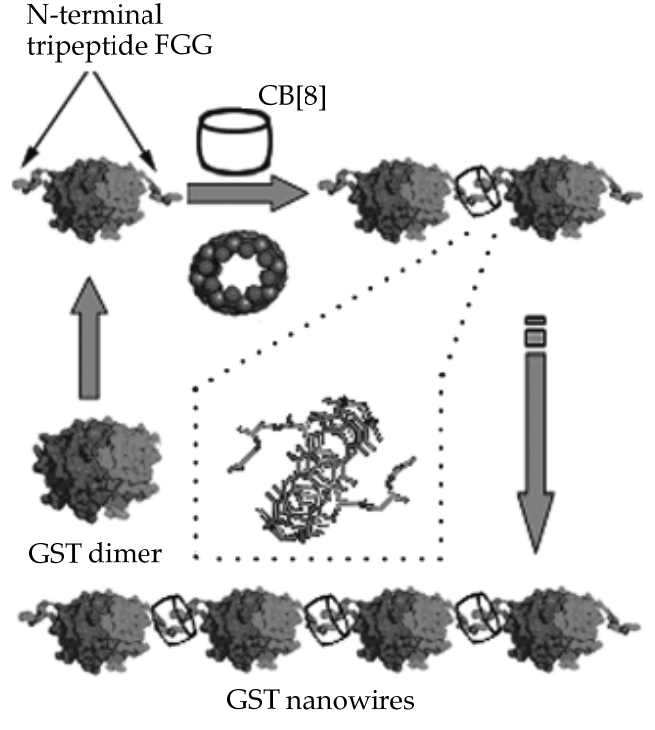
Figure 10. Formation of protein nanowires by CB[8]-based host–guest interactions.